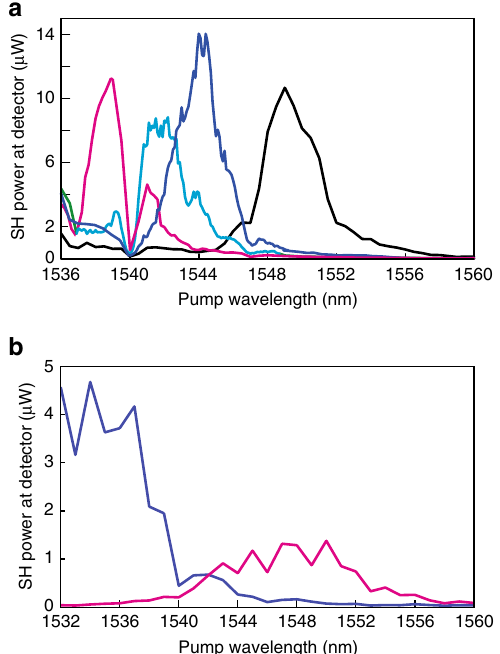
Fig. 3 Quasi-phase-matching evidence under continuous-wave probing. a Detected second harmonic power as a function of the probe wavelength in waveguide (i) for a continuous-wave (CW) coupled probe power of 350 mW. The waveguide was previously pumped at 1539 nm (magenta line), 1542 nm (cyan line), 1544 nm (blue line) and 1549 nm (black line). Phase- matching peaks are observed around each pump wavelength. b Detected second harmonic power as a function of CW probe wavelength for 130 mW of coupled power in waveguide (ii), previously pumped at either 1537 nm and 90 W coupled power (blue line) or 1550 nm and 60 W coupled